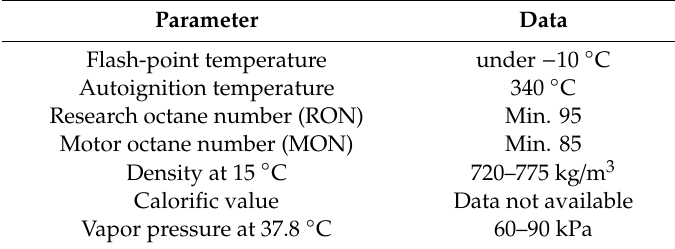
Table 3. Selected parameters of gasoline used to supply the ICE.